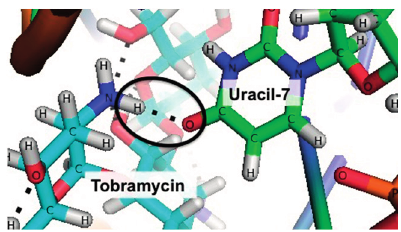
Figure 3. The uracil-7 site is a likely candidate for mutation to disrupt aptamer binding with target, thus reducing sensor affinity. We chose this site based on our criteria that it only has one polar contact (dashed lines) with tobramycin as determined via the NMR structure. This figure is generated from the previously reported NMR structure (PDB ID 2TOB) by Jiang and Patel